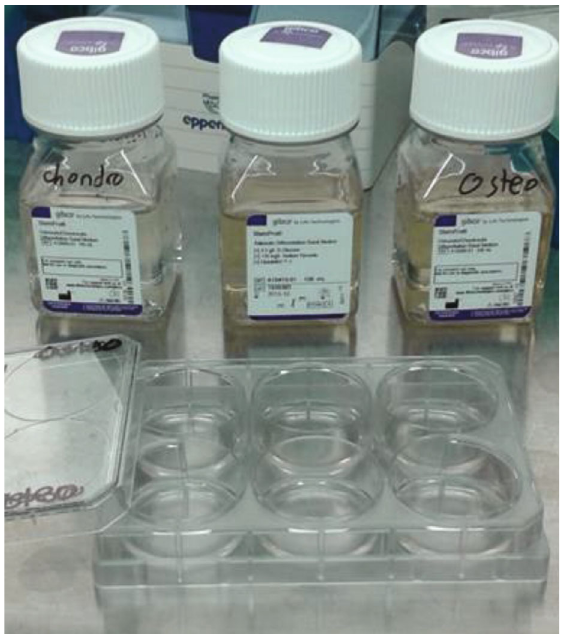
Figure 2: Ready-made osteogenic, adipogenic, and chondrogenic stem cell di ff erentiation media (Gibco StemPro, Thermo Fisher Scienti fi c, Massachusetts,